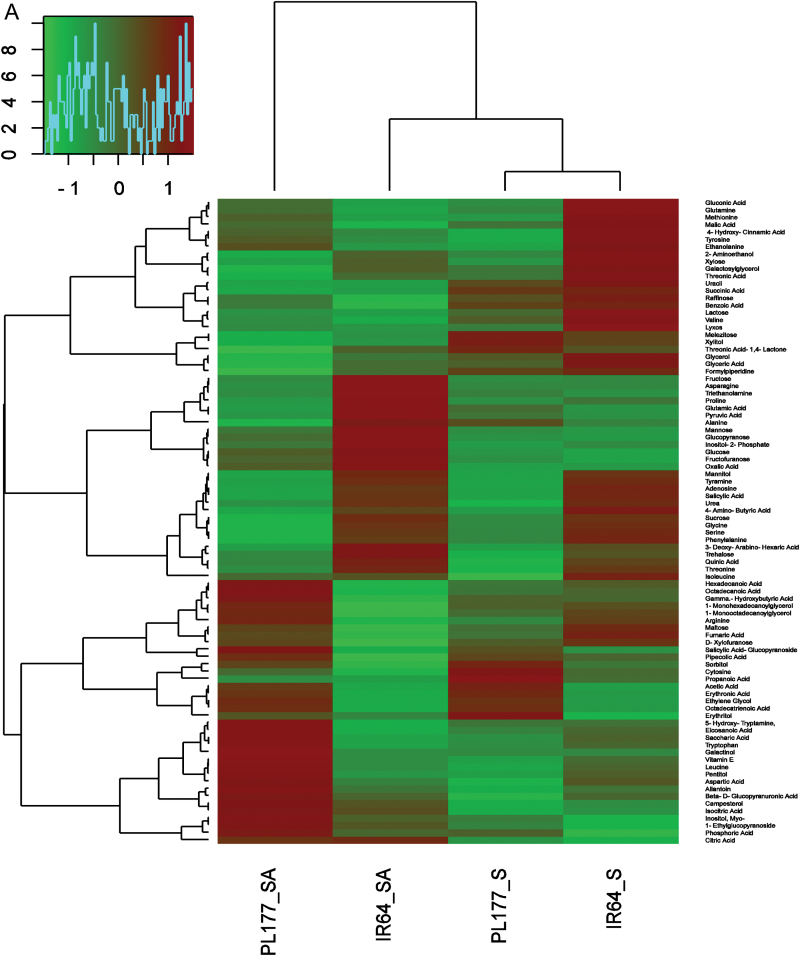
Results of hierarchical cluster analysis of changed metabolite pools. Hierarchical trees were drawn based on detected changed metabolites in shoots (A) and roots (B) of IR64 and PL177 under salt stress (S), salt stress+ABA (SA) treatments. (This figure is available in color at JXB online.)